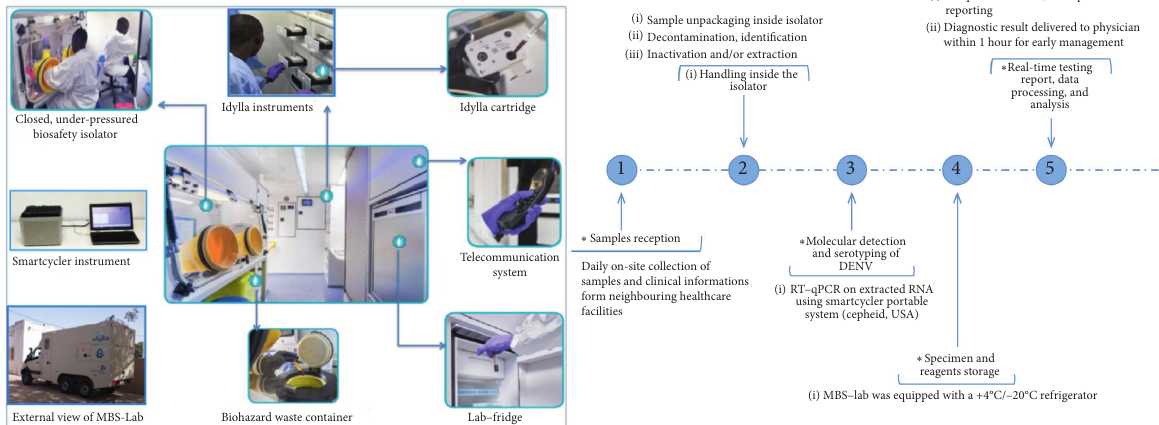
Figure 2: Mobile Biosafety Laboratory (MBS-Lab) workflow. (a) View and internal organization of MBS-Lab. (b) Workflow of dengue fever outbreak